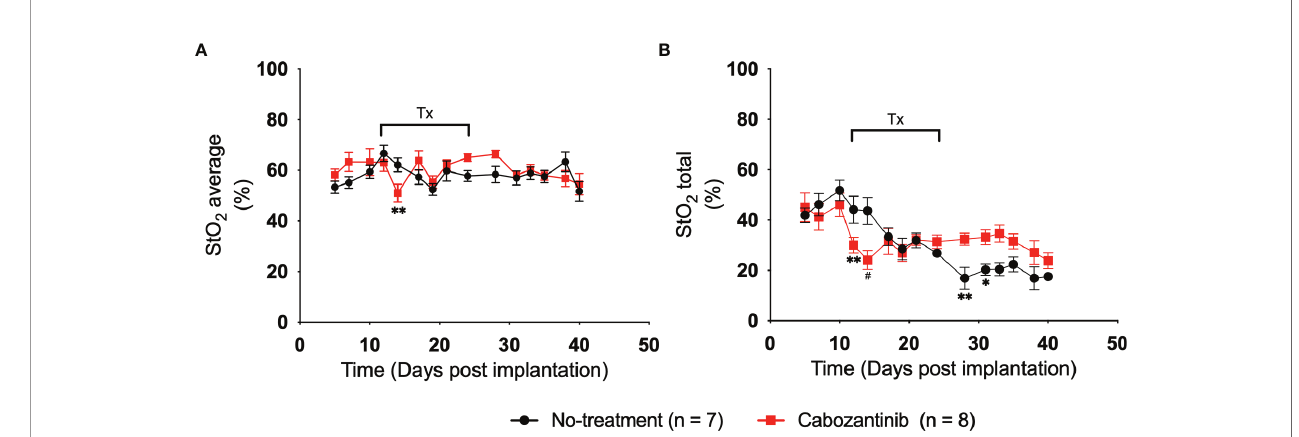
FIGURE 4 | (A) Plot of 3D average StO 2 in the tumors on different days post-implantation. Three days after treatment initiation, there is a statistically relevant difference between treated and non-treated tumors with a p-value of 0.0091. Error bars represent standard error of the mean (SEM) for each day post-implantation. (B) Plot of 3D total StO 2 on different days post-implantation. By performing multiple two-tailed unpaired t-tests, both 24 and 72 h posttreatment have signi fi cant differences between the values, with p-values of 0.0083 and 0.0003, respectively. Error bars represent SEM. * p < 0.05, ** p < 0.01, # p <